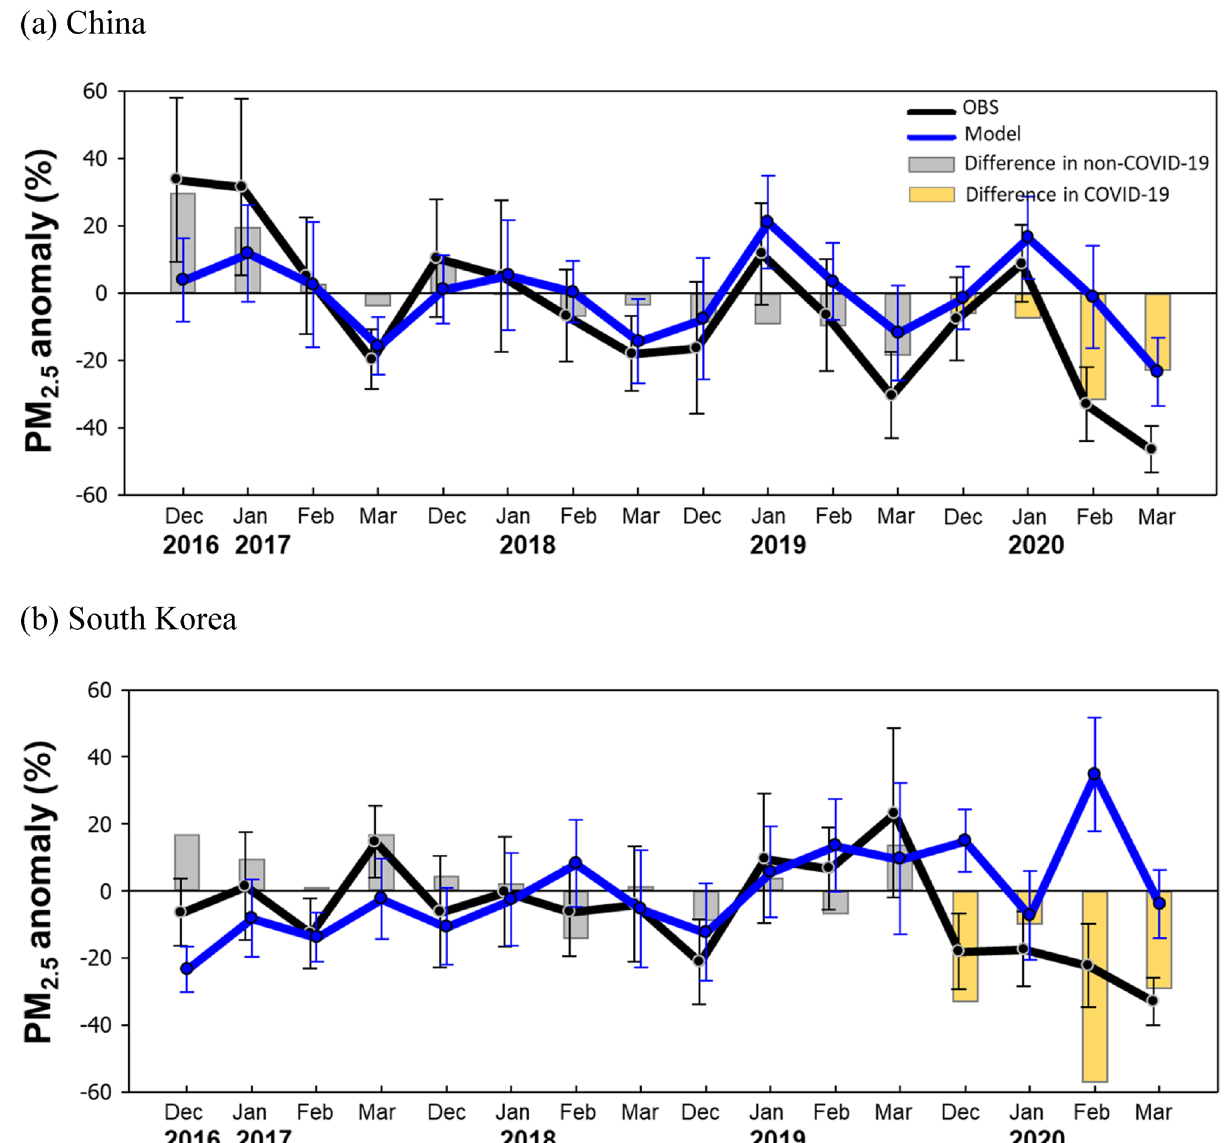
Figure 2. Difference between the observation-simulation anomalies of PM 2.5 in China and South Korea from December to March in 2016 to 2020. Average concentrations of simulated PM 2.5 were 58.9 μg/m 3 for China and 26.2 μg/m 3 for South Korea. Average concentrations of observed PM 2.5 were 62.2 μg/m 3 for China and 31.6 μg/ m 3 for South Korea. The blue line represents the anomaly for the simulated concentration and the black line represents the anomaly for the observed concentration. The gray and yellow bars represent the non-COVID-19 period and COVID-19 period,